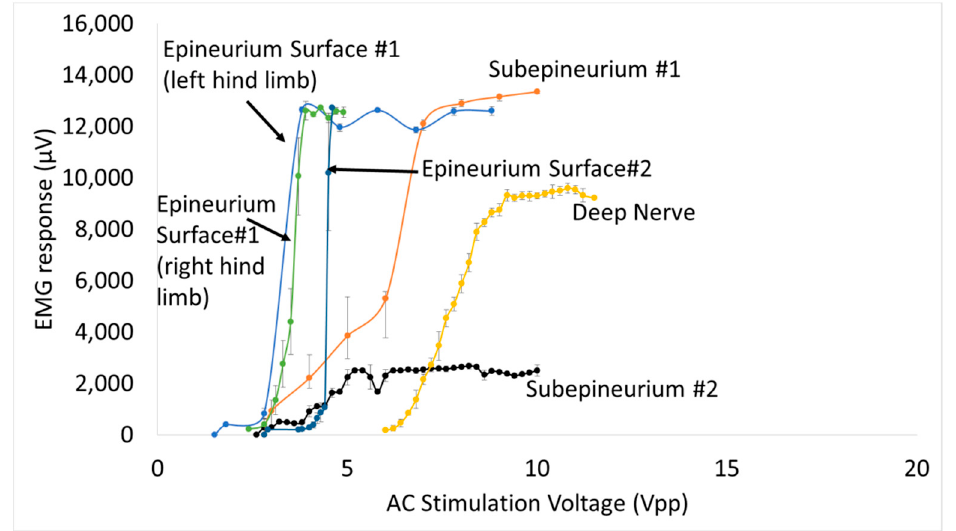
Figure 14. EMG recruitment curves for diodes implanted that are implanted subepineurially (2 animals) and deep in the sciatic nerve (one animal shown). A second animal with a deep nerve implant showed a response only at 20 Vpp (not shown). In addition, EMG recruitment curves of three diodes placed on the sciatic nerve is also shown labeled “epineurium surface #1’ and ‘epineurium surface #2’. Each data point is represented by the mean ± standard deviation of EMG responses to 10 stimulations at a given amplitude.